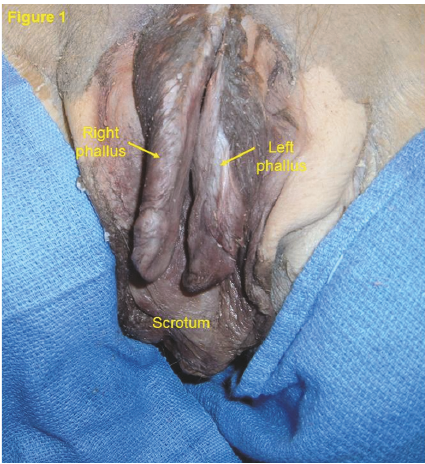
Figure 1: Complete bifid penis. The divided phallus was 9.2 cm long and divided longitudinally into right and left halves. Each half has its own glans and prepuce and no urethra was found in the phallus.